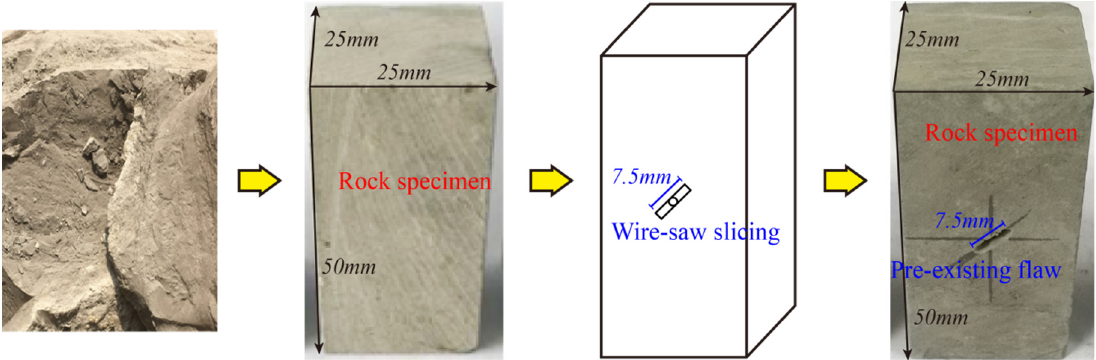
Figure 1. Preparation of mudstone specimens containing a pre-existing flaw.